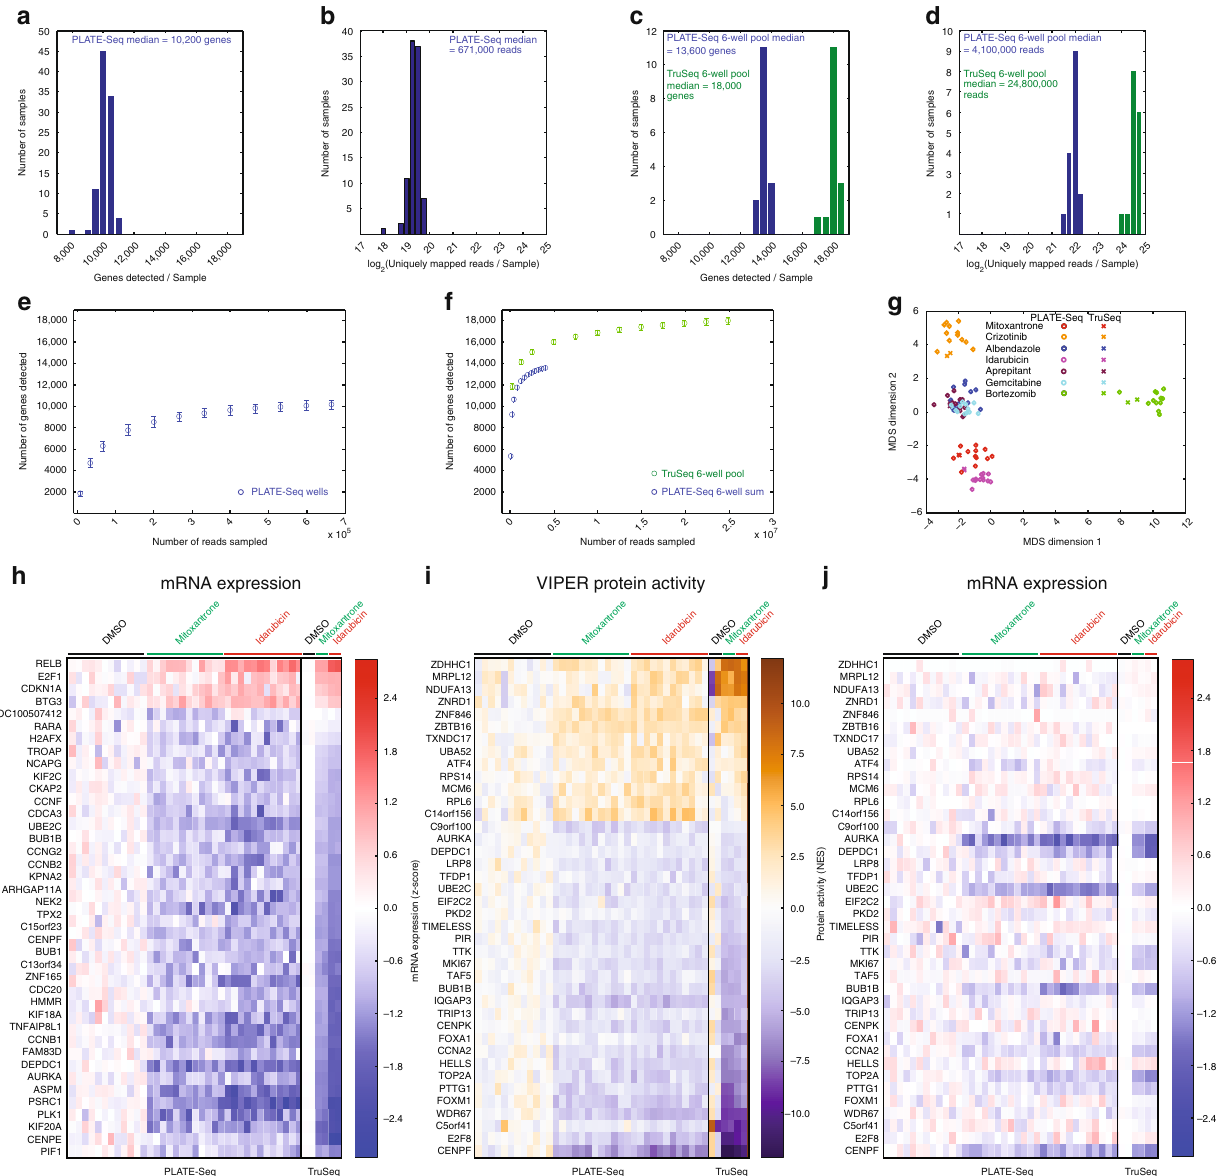
Fig. 2 PLATE-Seq performance. a Histogram of genes symbols detected per sample for a 96-well PLATE-Seq experiment in BT20 cells. b Histogram of uniquely mapped reads per sample for the experiment in a . c We pooled half of the sample from every six wells for conventional RNA-Seq with 30 M raw reads (Illumina TruSeq). Here we show a histogram of gene symbols detected per sample for each six-well TruSeq pool and for the sum of the corresponding six PLATE-Seq samples. d Same as c for uniquely mapped reads per sample. e Gene detection saturation curve for PLATE-Seq samples based on random subsampling. The points represent the average over all 96 wells and the error bars are deviations s.e.m. f Same as e but for each six-well TruSeq pool and for the sum of the corresponding six PLATE-Seq samples. g MDS clustering of PLATE-Seq and TruSeq samples based on differentially expressed genes identifying using the PLATE-Seq replicates for each drug compared to vehicle control samples. The PLATE-Seq replicates for each drug cluster together and also with the corresponding TruSeq samples. h Heat map showing the top 40 most differentially expressed genes based on PLATE-Seq of mitoxantrone- and idarubicin-treated BT20 cells measured with both PLATE-Seq and TruSeq. The two drugs are both topoisomerase II inhibitors and have similar gene expression signatures. i Same as h but with differentially active proteins as inferred using VIPER. Note that TOP2A, the gene that encodes the target of the two drugs, is strongly deactivated. j Gene expression of differentially active proteins inferred using VIPER. Most of these genes are not differentially expressed and some are dif fi cult to detect with PLATE-Seq, yet VIPER can still infer their